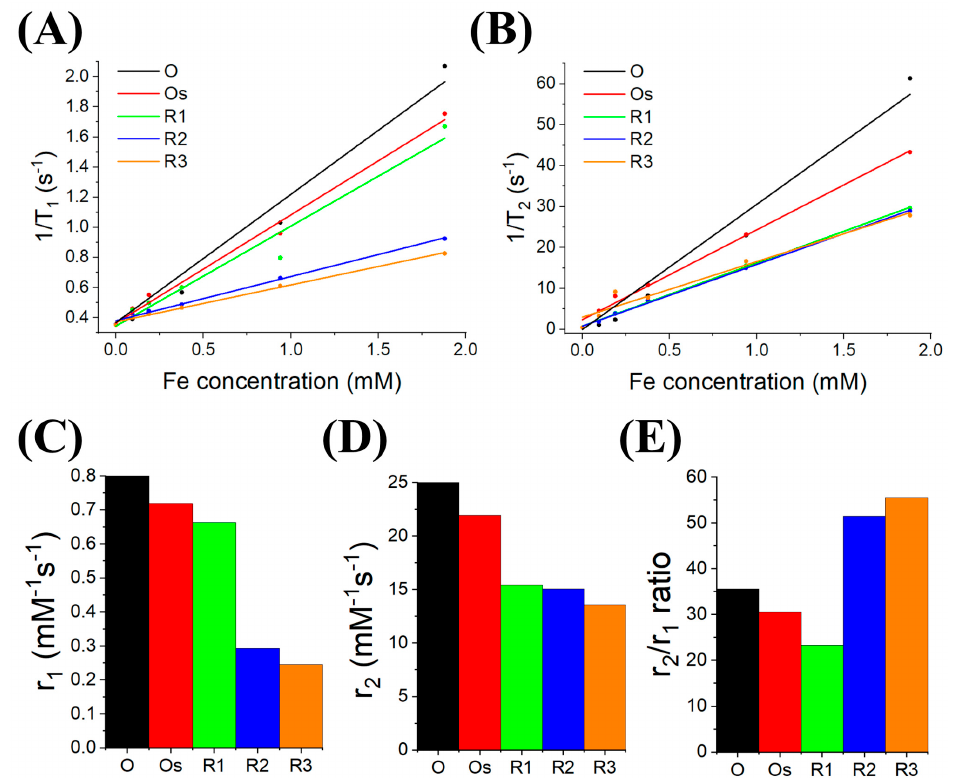
Figure 3. Nuclear magnetic resonance (NMR) of the various stages of magnetic-plasmonic nanostructures. ( A ) shows the T 1 relaxation time (s − 1 ) of the various nanostructures at different concentrations of iron (mM). ( B ) shows the graph of the T 2 relaxation time with varied concentrations of the multistage nanoparticles. ( C , D ) are bar graphs of the relaxivities r 1 and r 2 , respectively. ( E ) shows the r 2 / r 1 ratio of the magnetic-plasmonic nanostructures.